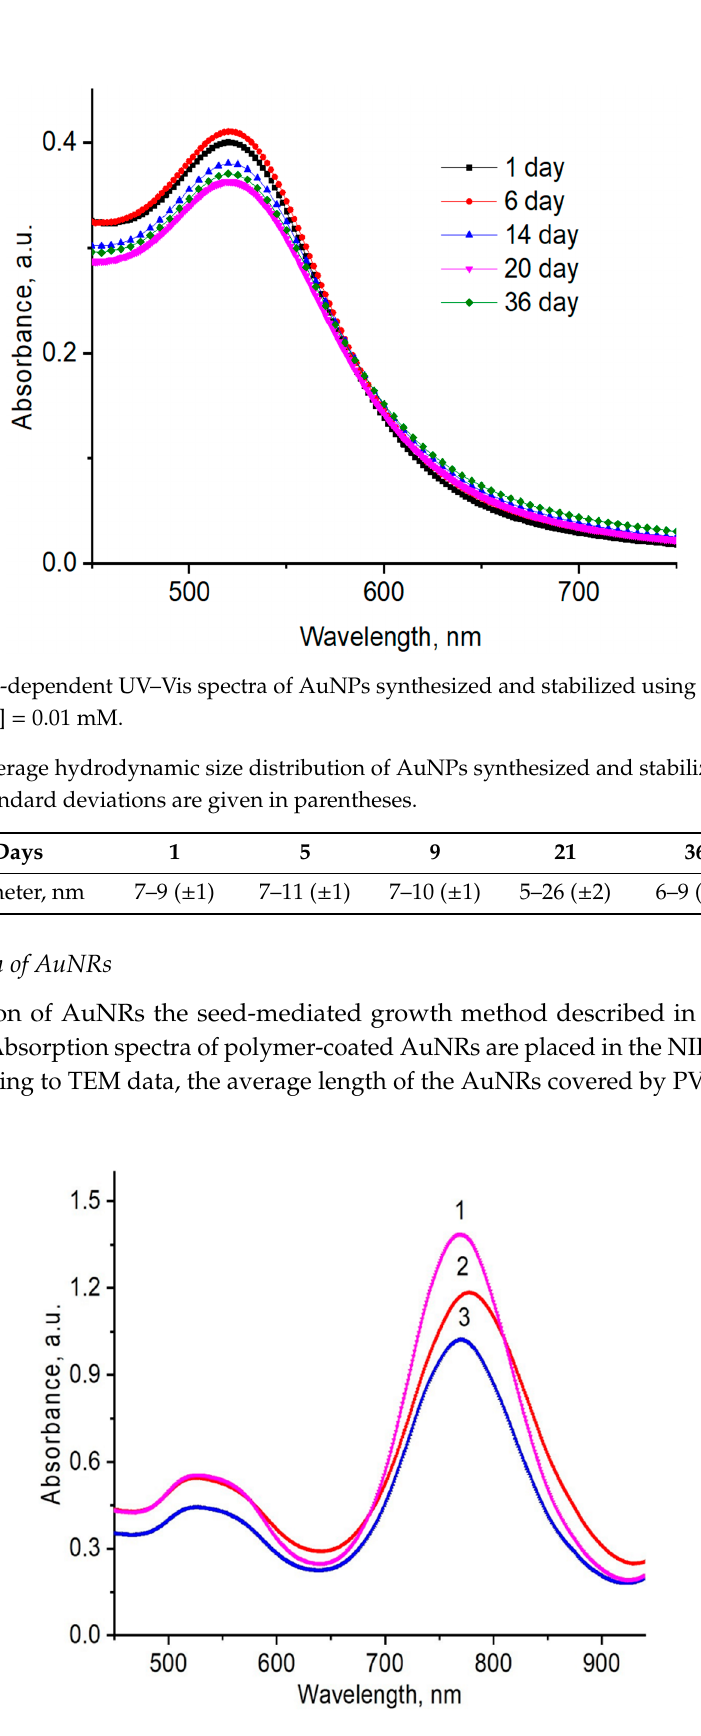
Figure 16. UV–Visible spectra of AuNRs synthesized and stabilized using PVP (1), PVCL (2), and gellan (3) after separation from CTAB, and washing with deionized